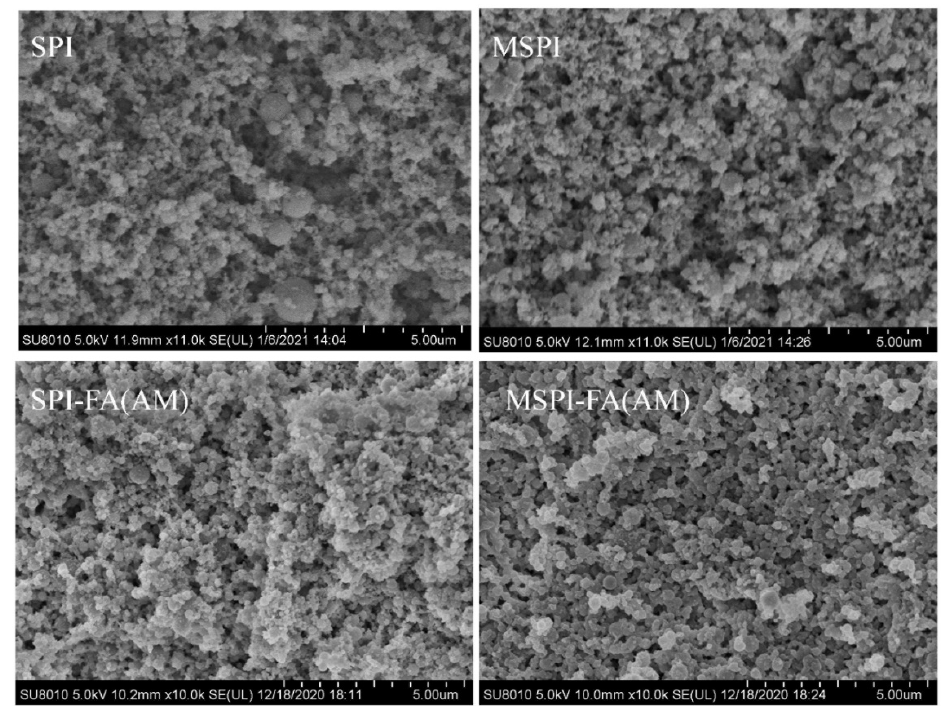
Molecules 2022 , 27 , x FOR PEER REVIEW Figure 4. SEM microscopy of emulsion gels induced by different modified soybean protein isolates.